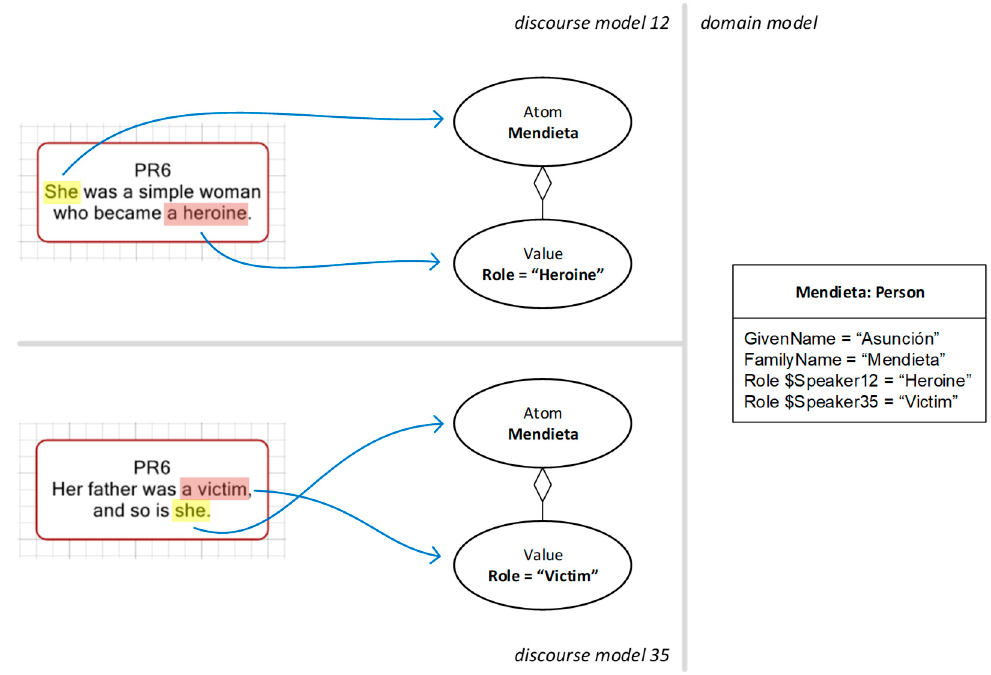
Figure 13. Discourse and domain models for the fragments above. Note that the two discourse models share a common domain model.